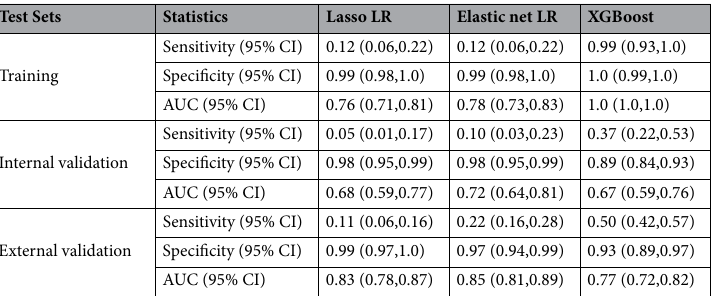
Test Sets Statistics